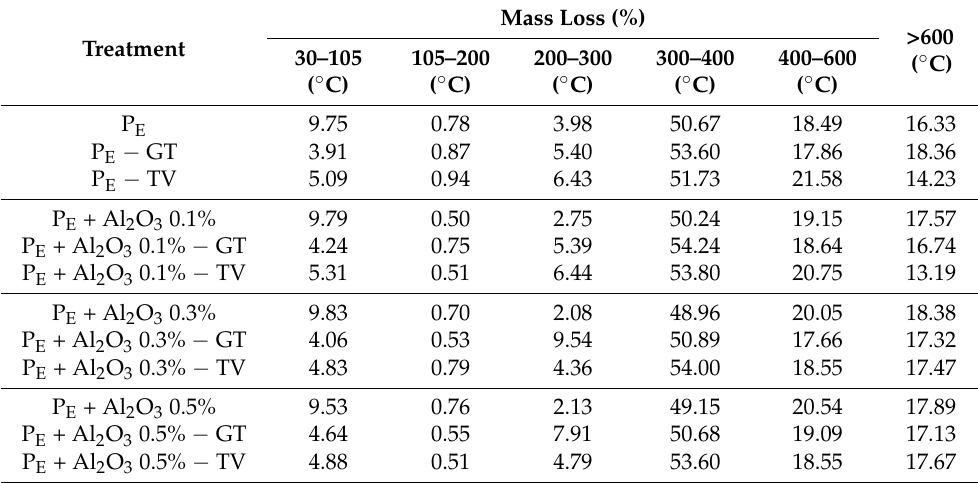
Table 1. Mass losses for different temperature ranges of the treated and untreated P. elliottii (P E ) woods exposed to the G. trabeum (GT) and T. versicolor (TV) fungi.